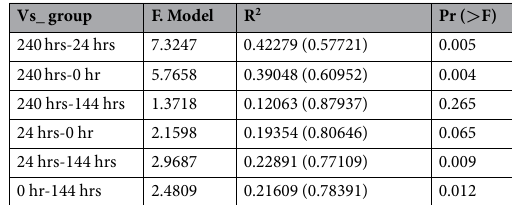
Table 1. Adonis Group Difference Analysis of microbial communities’ composition between different PMI. F. Model is F test value. R 2 indicates the interpretation degree of sample difference in different groups, that is, the larger the ratio of group variance to total variance is, the higher the interpretation degree of the group to the difference is. In addition, the Pr is P value, and less than 0.05 means that the reliability of this test is high. The value of the residuals in